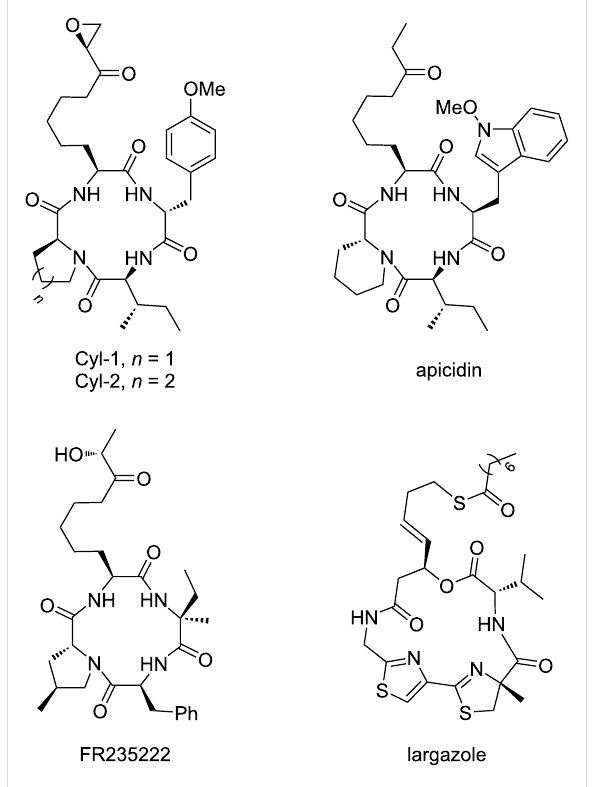
Figure 2: Naturally occurring HDAC inhibitors with different zinc- binding